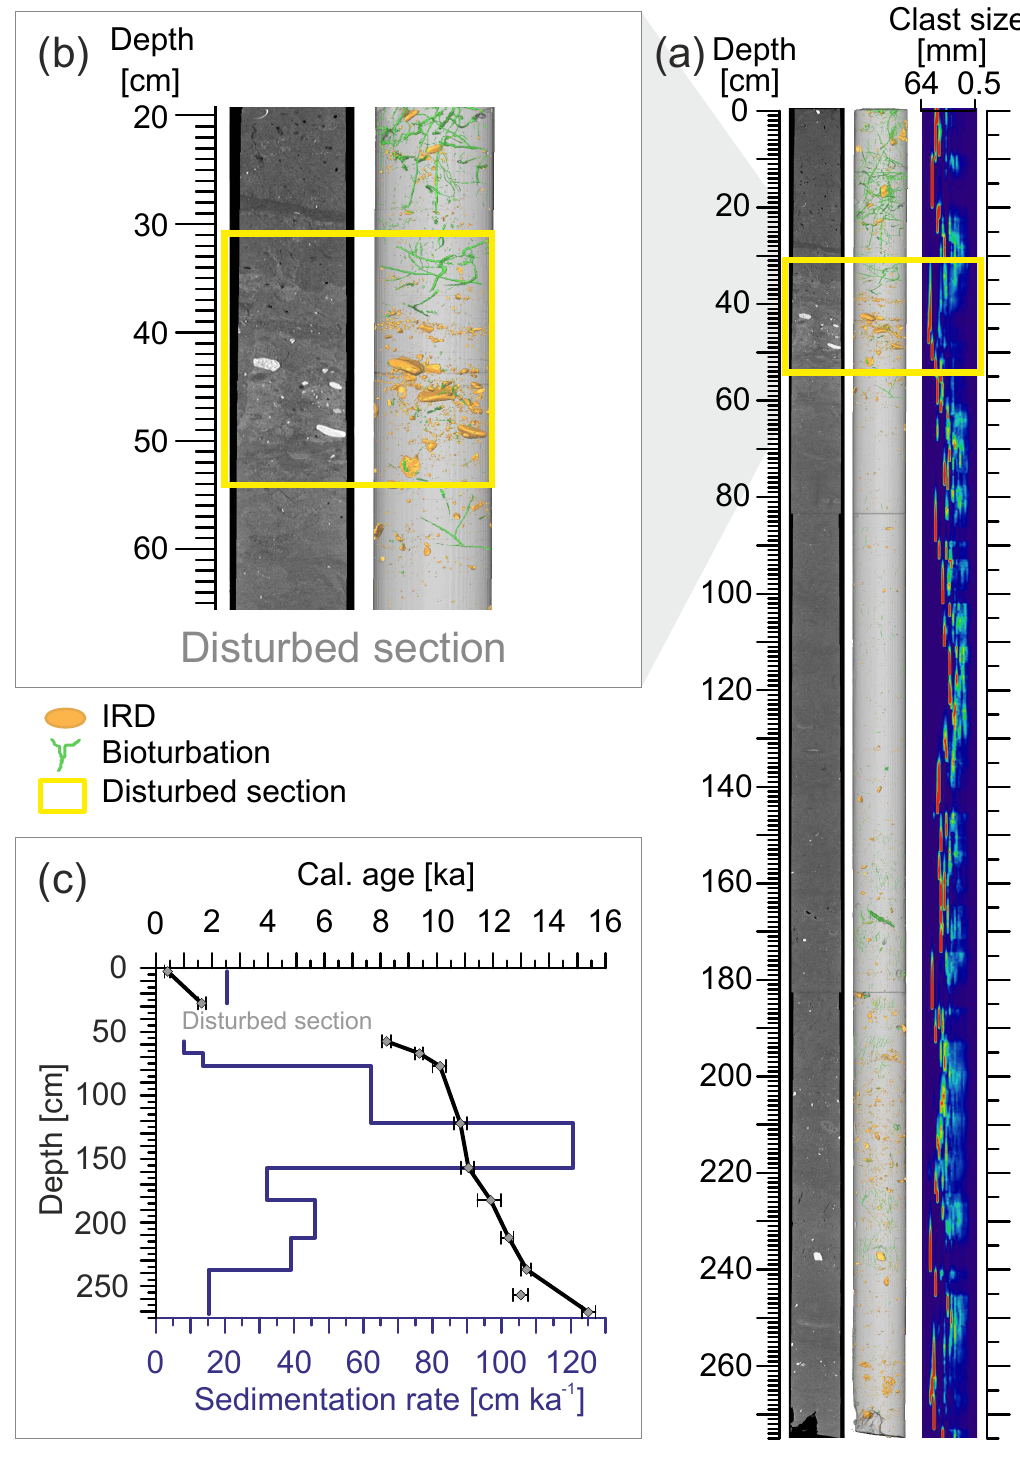
Figure 3. (a) CT scan of the core GeoB10817-4. Left to right: orthogonal profile; interpreted image (clasts and bioturbation; see legend); clast size distribution (0–20vol.% of clasts: blue to red, respectively). The yellow rectangle marks the disturbed section also shown in (b) . (b) CT images (orthogonal and interpreted) of the disturbed section (yellow rectangle; definition of boundaries; see Sect. 4.1 and Fig. A2 in the Appendix). (c) Age–depth plot for sediment core GeoB10817-4: the diamonds show calibrated (median) ages with error bars (Table 1); the solid black line shows linear interpolation excluding an outlier at 257cm. The blue solid line shows corresponding sedimentation